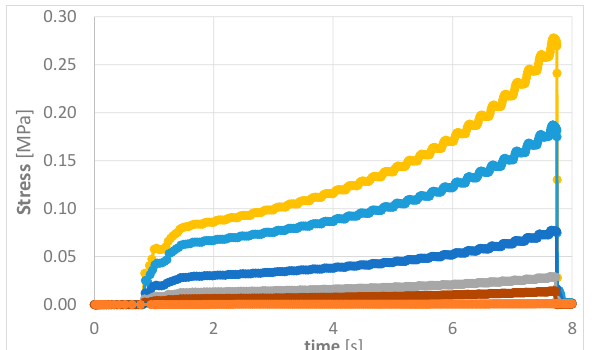
Figure 6. Existing wafer and panel sizes influencing fan-out panel level packaging developments.